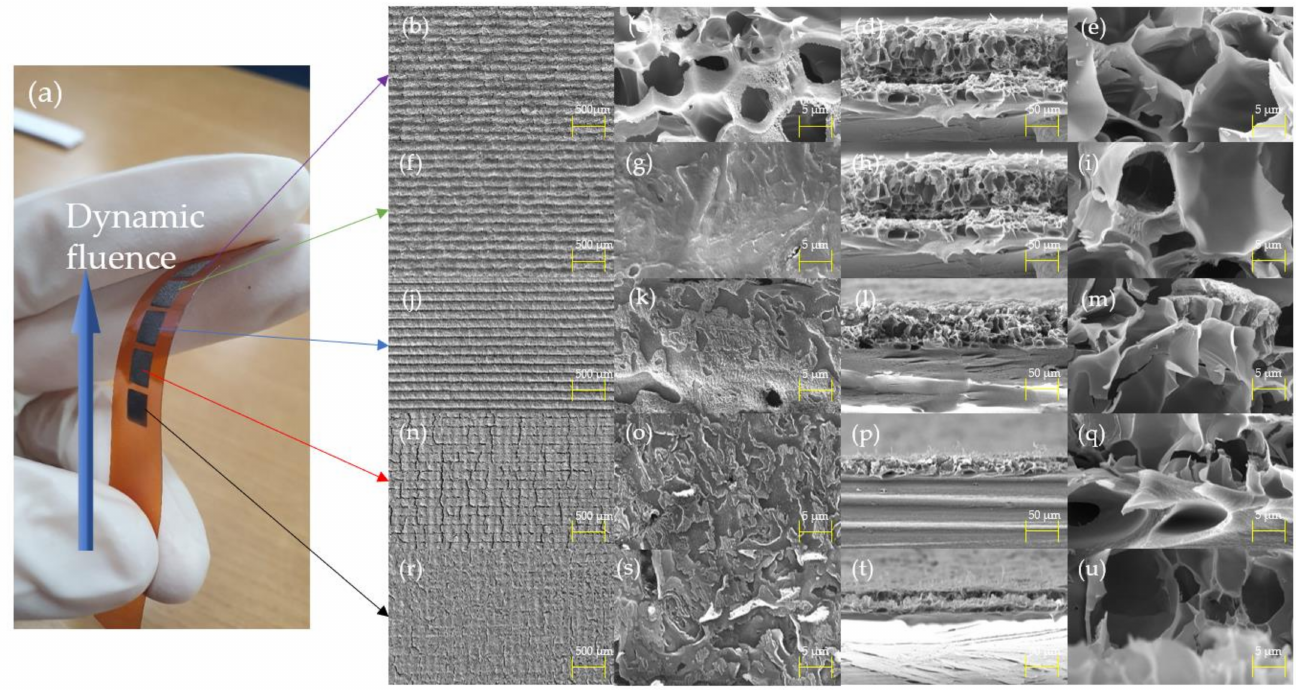
Figure 2. ( a ) Actual photograph of LIG patterns. FE-SEM images of LIG patterns fabricated at a laser scanning speed of ( b – e ) 20 mm/s, ( f – i ) 40 mm/s, ( j – m ) 60 mm/s, ( n – q ) 80 mm/s, and ( r – u ) 100